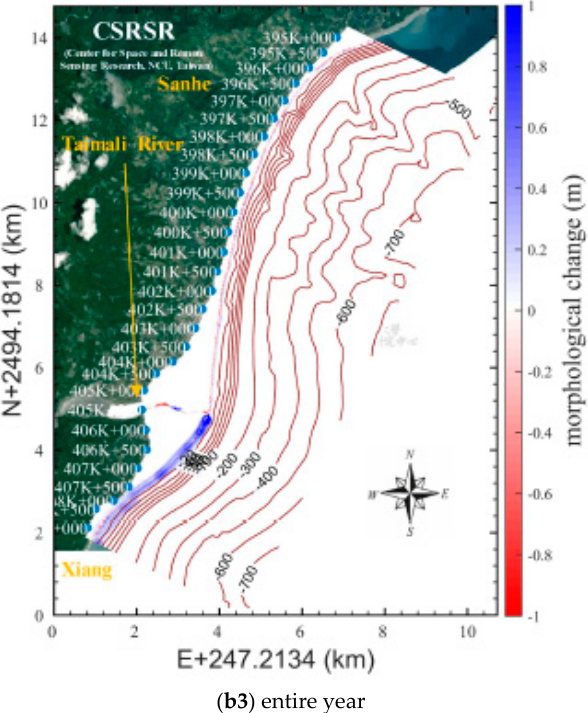
Figure 24. Simulated coastal current and morphological change in Region C. ( a ): coastal current; ( b ): morphological change.